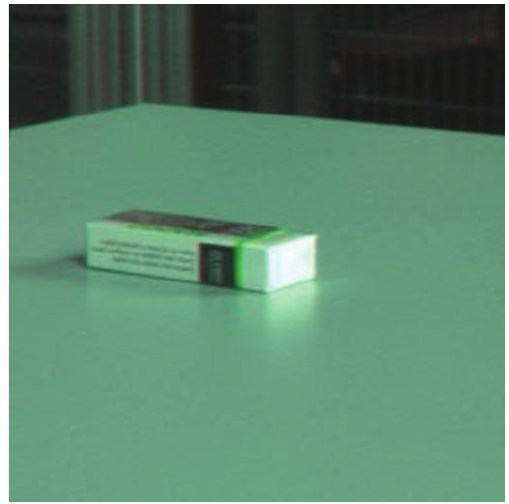
Figure 6: Eraser at 𝜃 = 10 ∘ and 𝜙 = 54 ∘ .